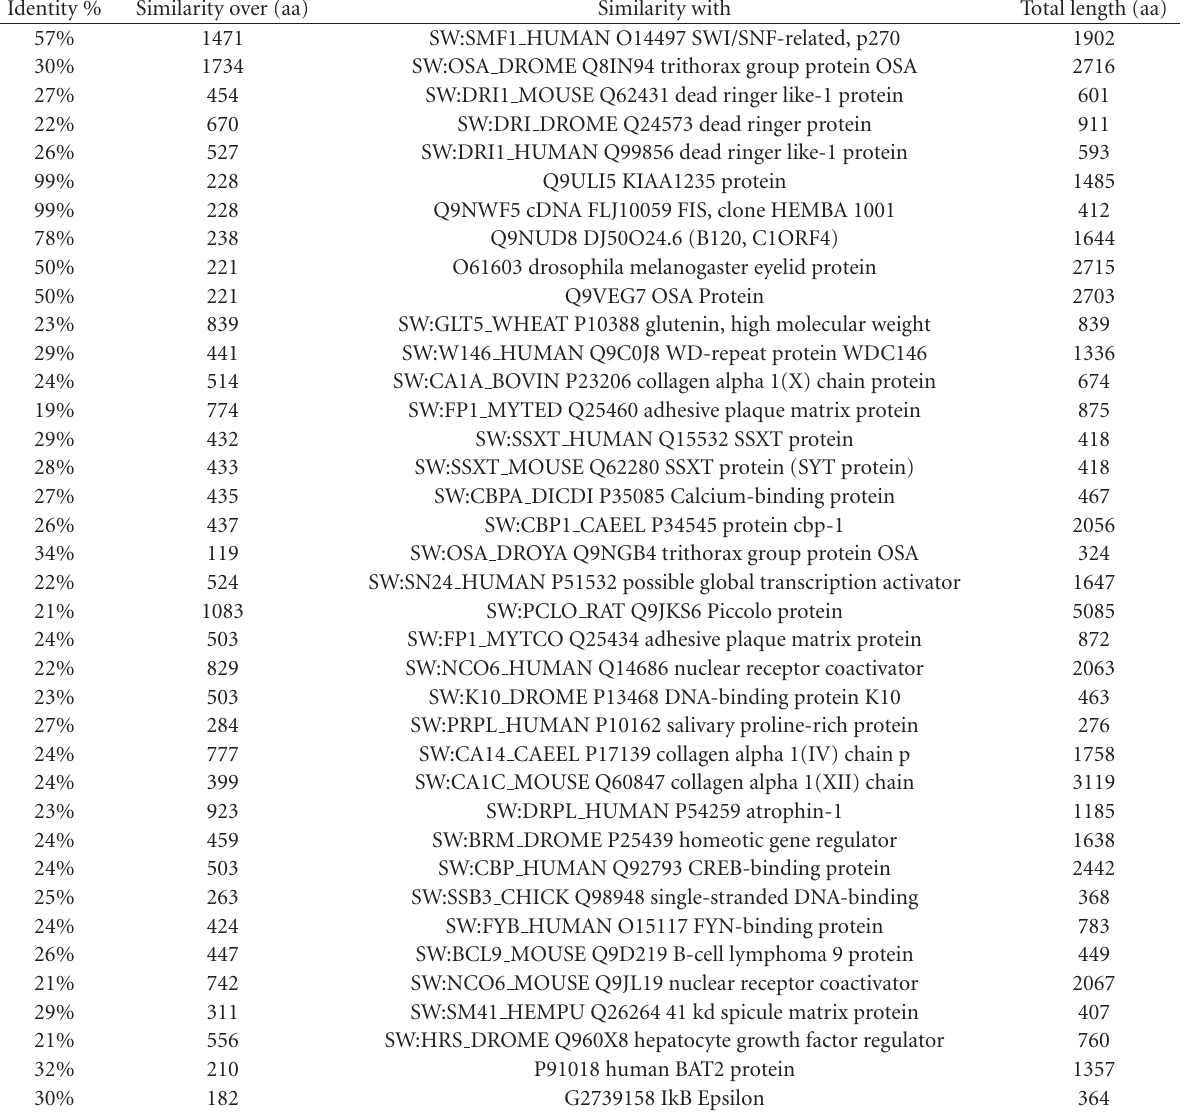
Table 3. Similarities of rat 6A3-5 to known proteins in the databases. After comparison to all protein databases (SWISSPROT, TREMBL, PIR, ... ), we had only few similarities to known proteins. The best similarities were with a number of transcription factors. p270 and b120 had 78% identity (83% similarity matching) while eyelid had 52% identity (61% similarity matching) with